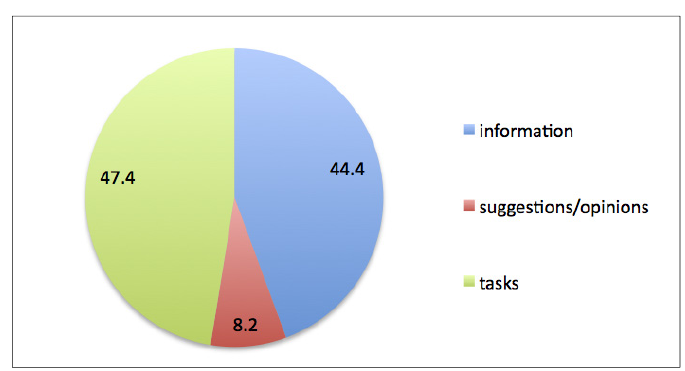
Figure 2. Types of questions in the analyzed